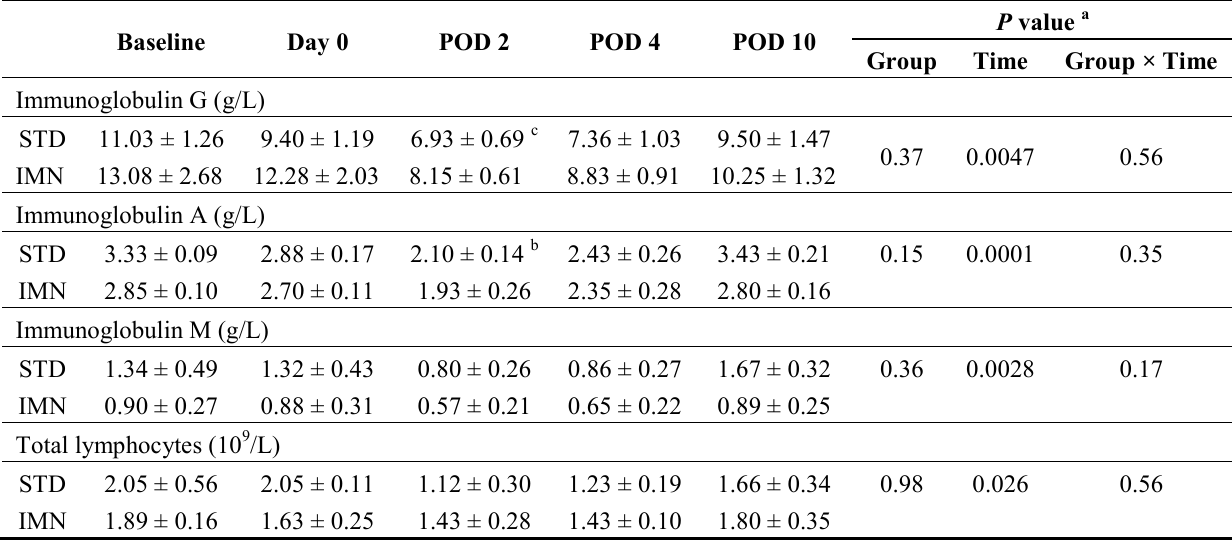
Table 3. Immunoglobulin G, A, M and total lymphocyte concentrations (mean ± SEM)